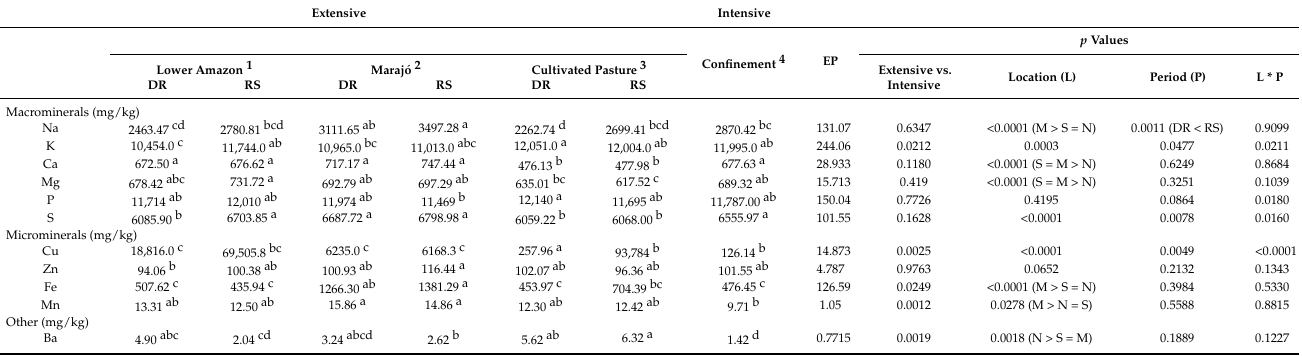
Table 2. Mineral composition in the liver of Murrah × Mediterranean crossbred buffaloes raised intensively and extensively in three types of ecosystems in the Amazon (Brazil), in the dry (DR) and rainy (RS) periods of the year ( n = 12), and one in